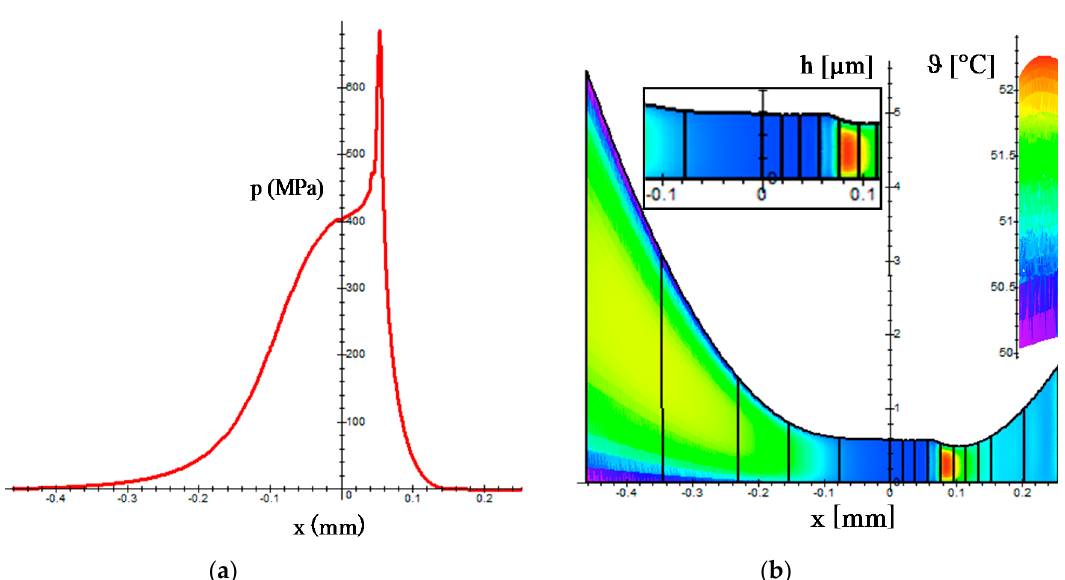
Figure 3. ( a ) Pressure distribution in the case of pure rolling contact S = 0. ( b ) Temperature distribution in the case of pure rolling contact S = 0 .